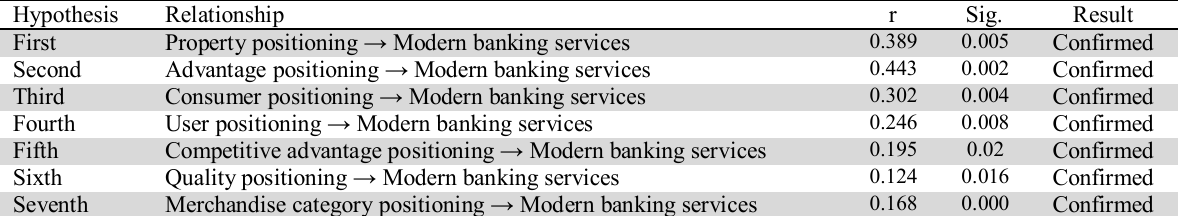
The results of testing the effect of positioning strategies on development of modern banking system based on Spearman